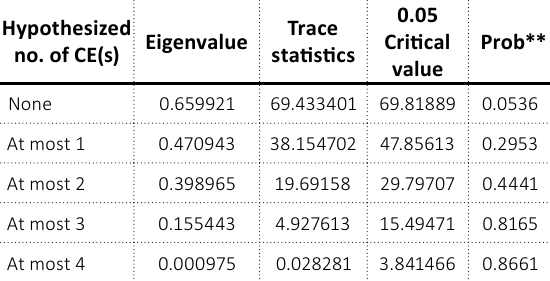
Table 4. Unrestricted cointegration rank test (trace)